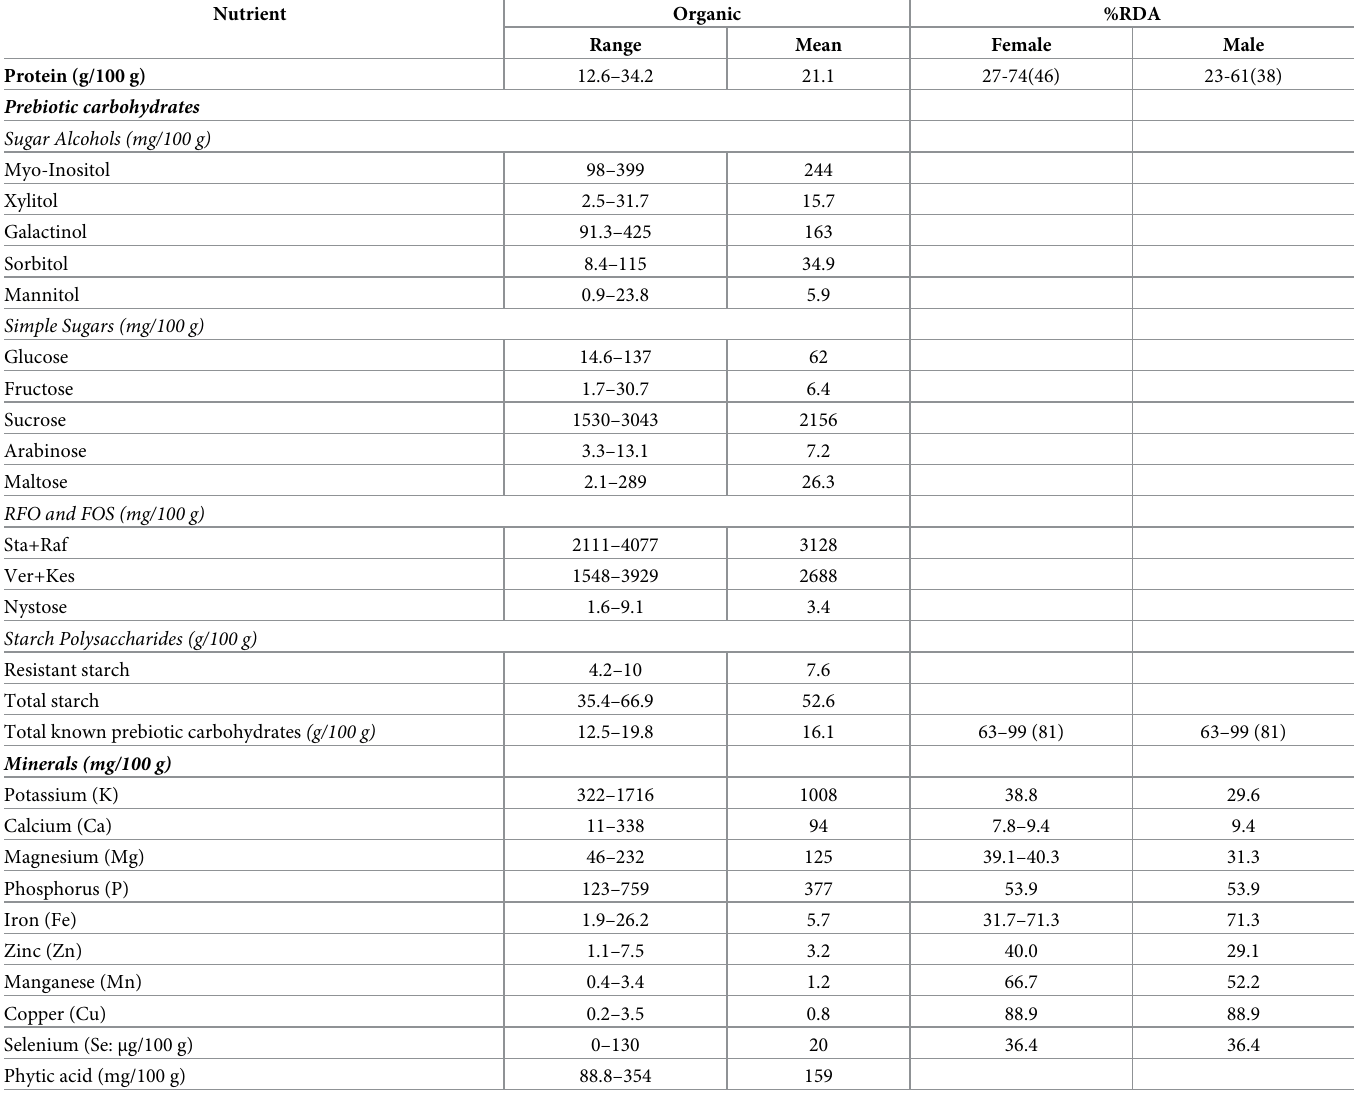
Table 5. Range and mean nutrient concentrations of organic dry pea grown in